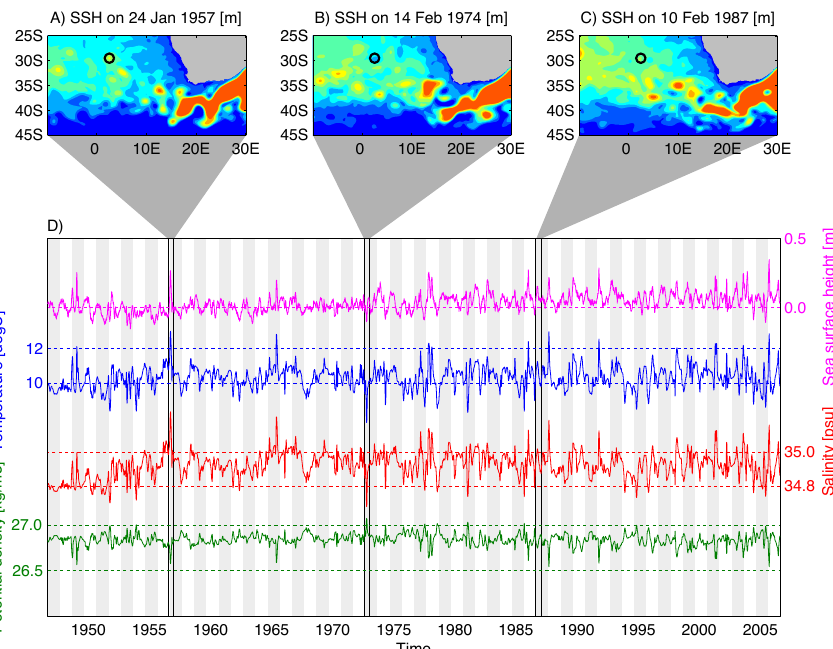
Fig. 3. Analysis of model INALT01 output. (A) , (B) , and (C) : SSH maps showing the position of Agulhas rings with respect to the core location, in three selected situations recurring in the time series (D) of SSH, temperature, salinity and density at 452m, for the period 1948– 2007. (A) : full overlap with an Agulhas ring (SSH peak); (B) : overlap with a cyclone (trough); (C) : partial overlap with an Agulhas ring (small perturbation in the